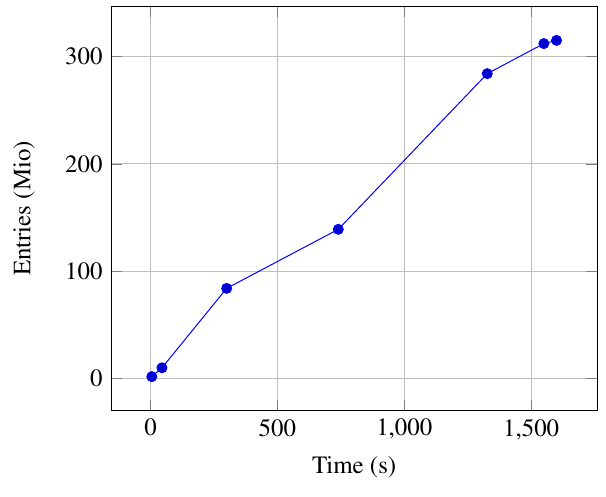
Figure 2. Namespace metadata load time